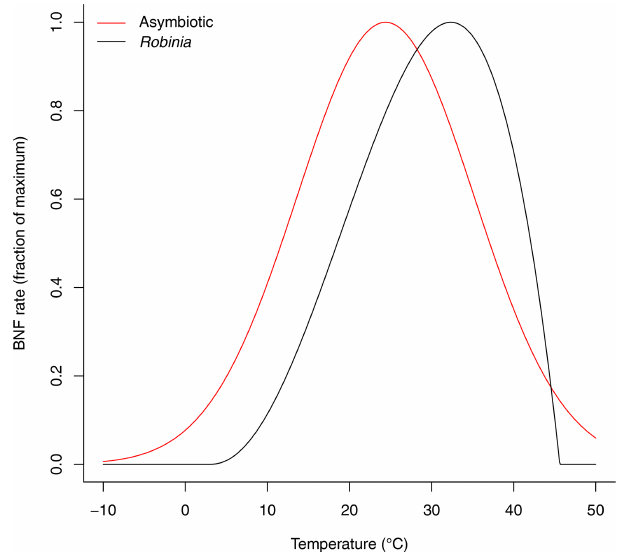
Figure 2. Soil temperature dependence function of asymbiotic BNF and symbiotic BNF by Robinia . Asymbiotic BNF reaches its max- imum at 24.4 ◦ C and is derived from Houlton et al. (2008). Symbi- otic BNF by Robinia reaches its maximum at 31.9 ◦ C and is derived from Bytnerowicz et al.